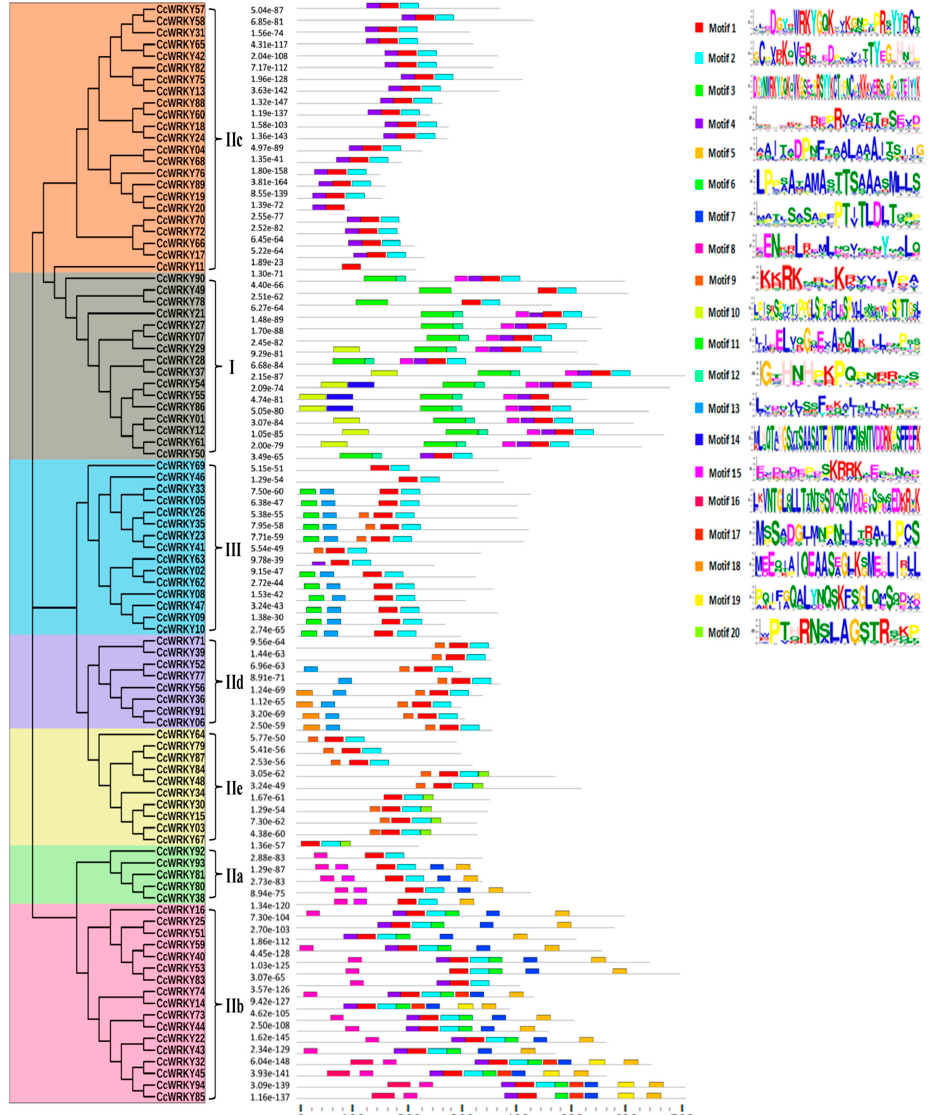
Figure 4. Schematic distribution of 20 conserved motifs predicted in 94 pigeonpea WRKY proteins.